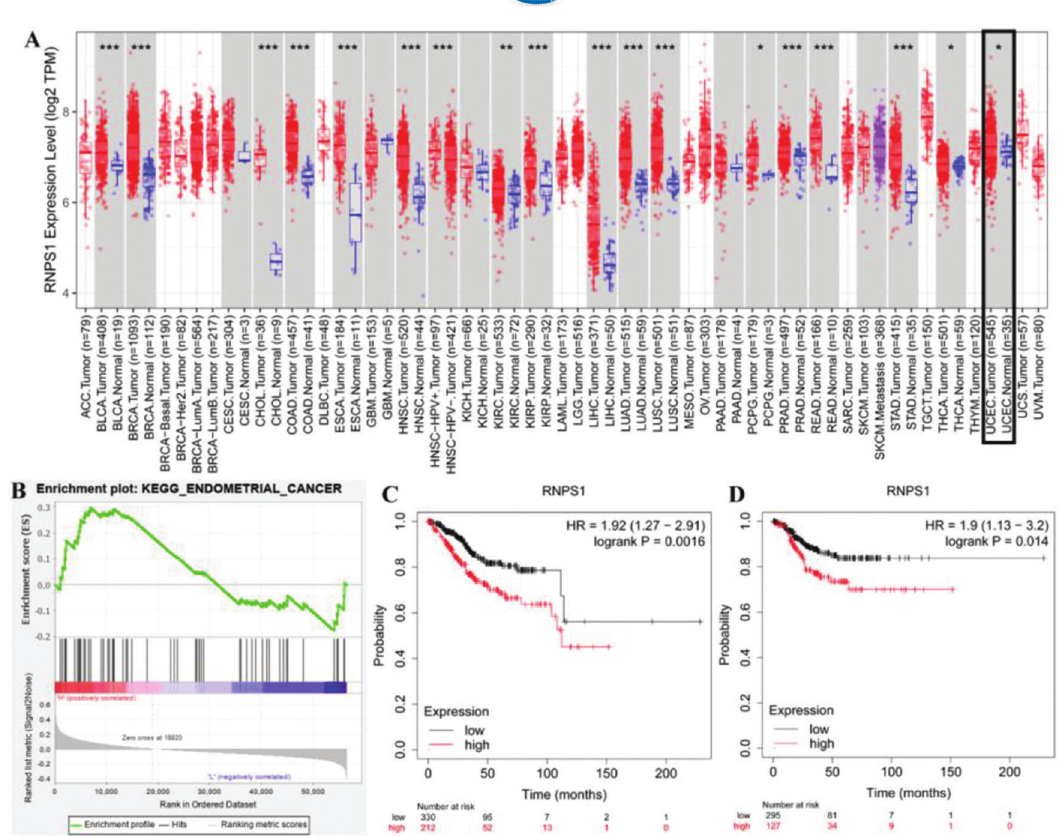
Figure 1 - (A) Assessment of RNPS1 expression in cancers. (B) GSEA of the correlation between RNPS1 and UCEC. (C) OS and (D) RFS analyses of the role of RNPS1 in UCEC